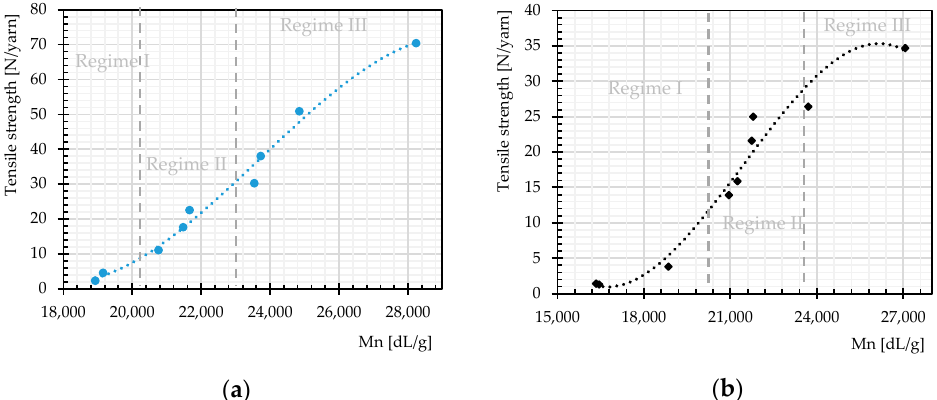
Figure 14. Tensile strength as function of molecular weight regimes, different weathering durations: ( a ) warp direction; and ( b ) weft direction.